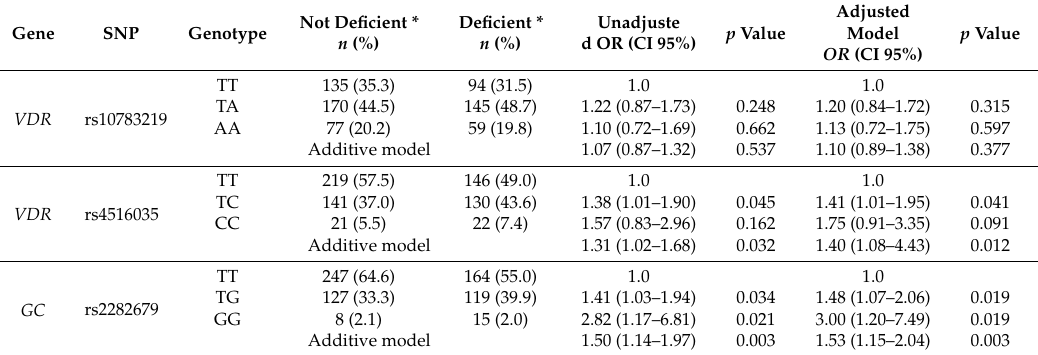
Table 3. Odds ratios for the association of vitamin D metabolism genetic variants and vitamin D deficiency in a sample of 689 postmenopausal